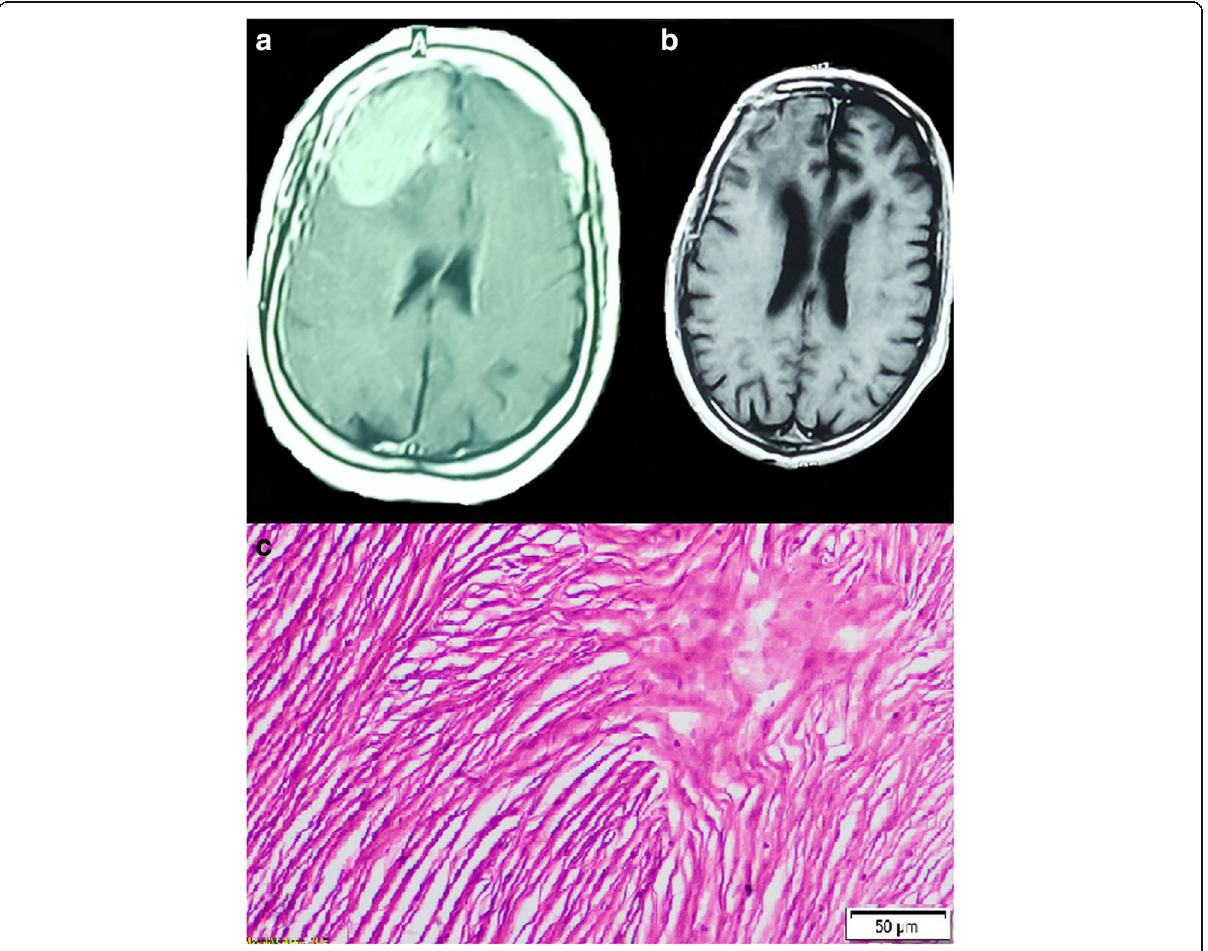
Fig. 2 Convexity meningioma. a Preoperative image, MRI with contrast (axial) showed mass lesion in the right frontal region. The tumor was surrounded by mild edema. b One year postoperative MRI with contrast (axial) revealed complete removal of the mass. Geriatric Scoring System (GSS) score = 16. c The slide represented fibrotic meningioma, WHO grade